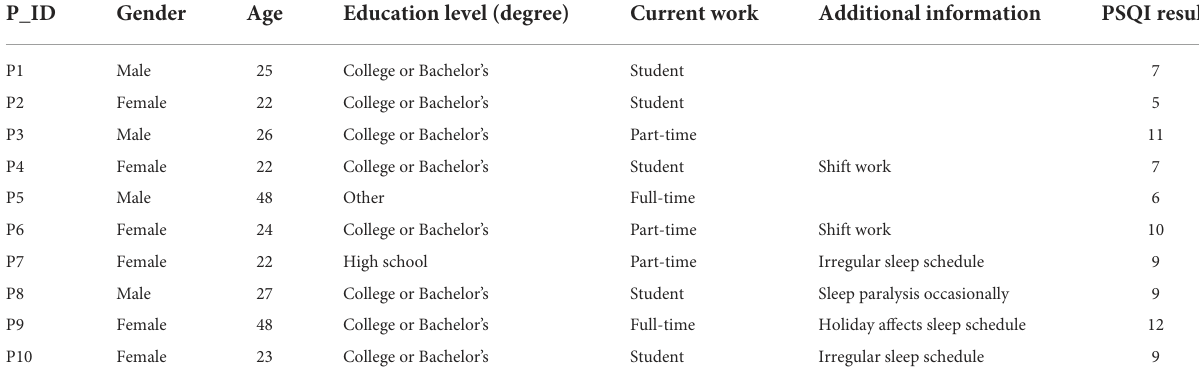
TABLE 2 Participant